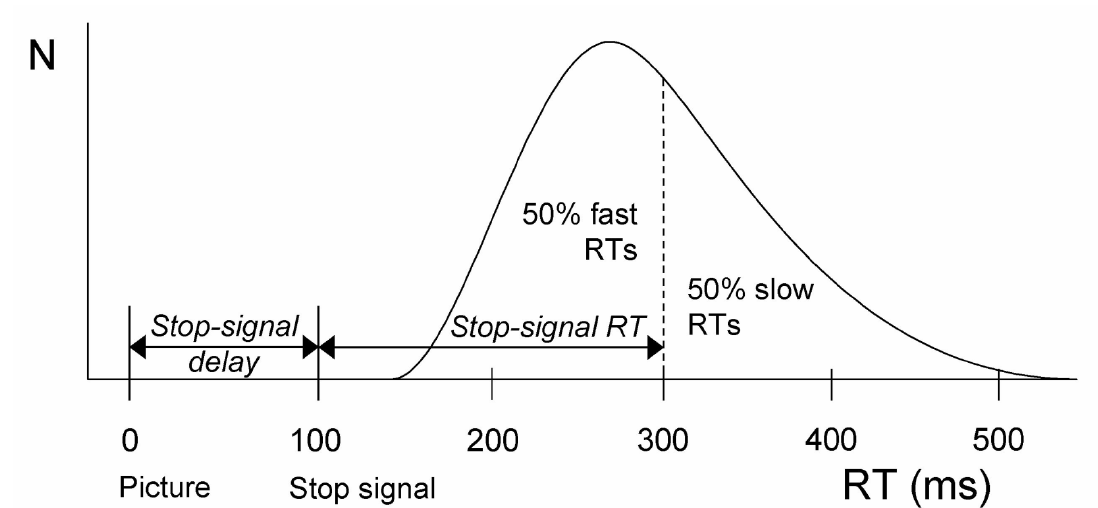
Figure 2. Integration method. Calculation of stop-signal RT (SSRT) according to the race model (Logan and Cowan, 1984). The black curve depicts the distribution of RTs on go trials (i.e., trials without a stop signal), representing the finishing times of the go process. Assuming independence of the go and stop processes, the finishing time of the stop process bisects the go RT distribution. Here, responses could not be stopped on 50% of the stop trials. Hence, the n-th go RT that represents the finishing time of the stop process is 300 ms. Go RTs shorter than 300 ms will win the race (resulting in failed stop trials), whereas go RTs longer than 300 ms will lose the race against the stopping process (resulting in successful stop trials). Here, subtracting mean stop-signal delay (100 ms) from the 50th percentile of go RT (300 ms) yields an estimated SSRT of 200 ms.